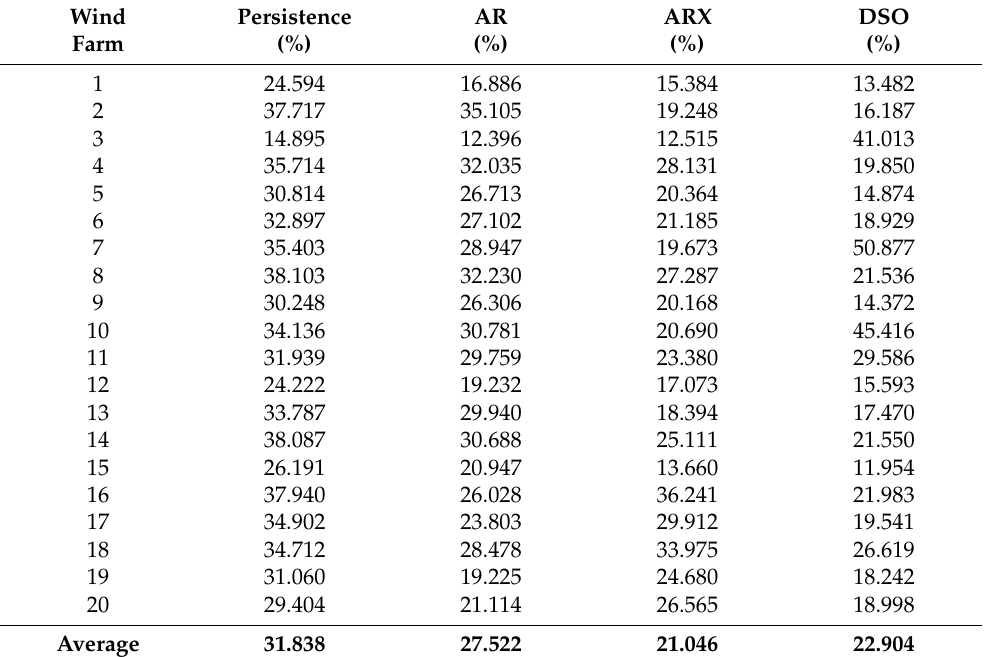
Table 2. RRMSE for Persistence, AR, and ARX: 6 months training, 1-month